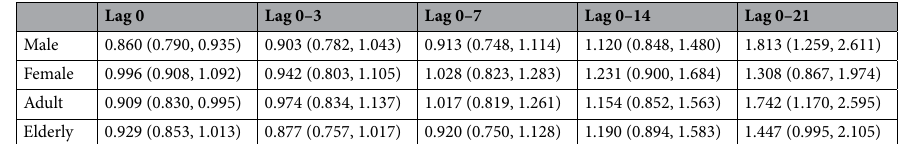
Table 3. For the gender and age subgroup, the cumulative effect of low DTR had an impact on the hospital admissions for CVD along the lag days.